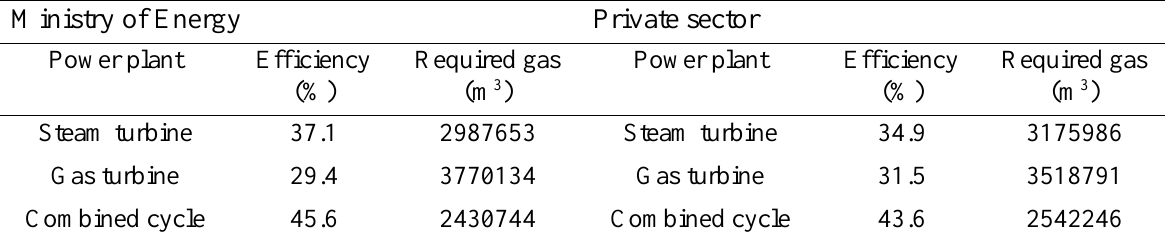
Table 2. The required amount of gas for generating 𝐸 ∗ .